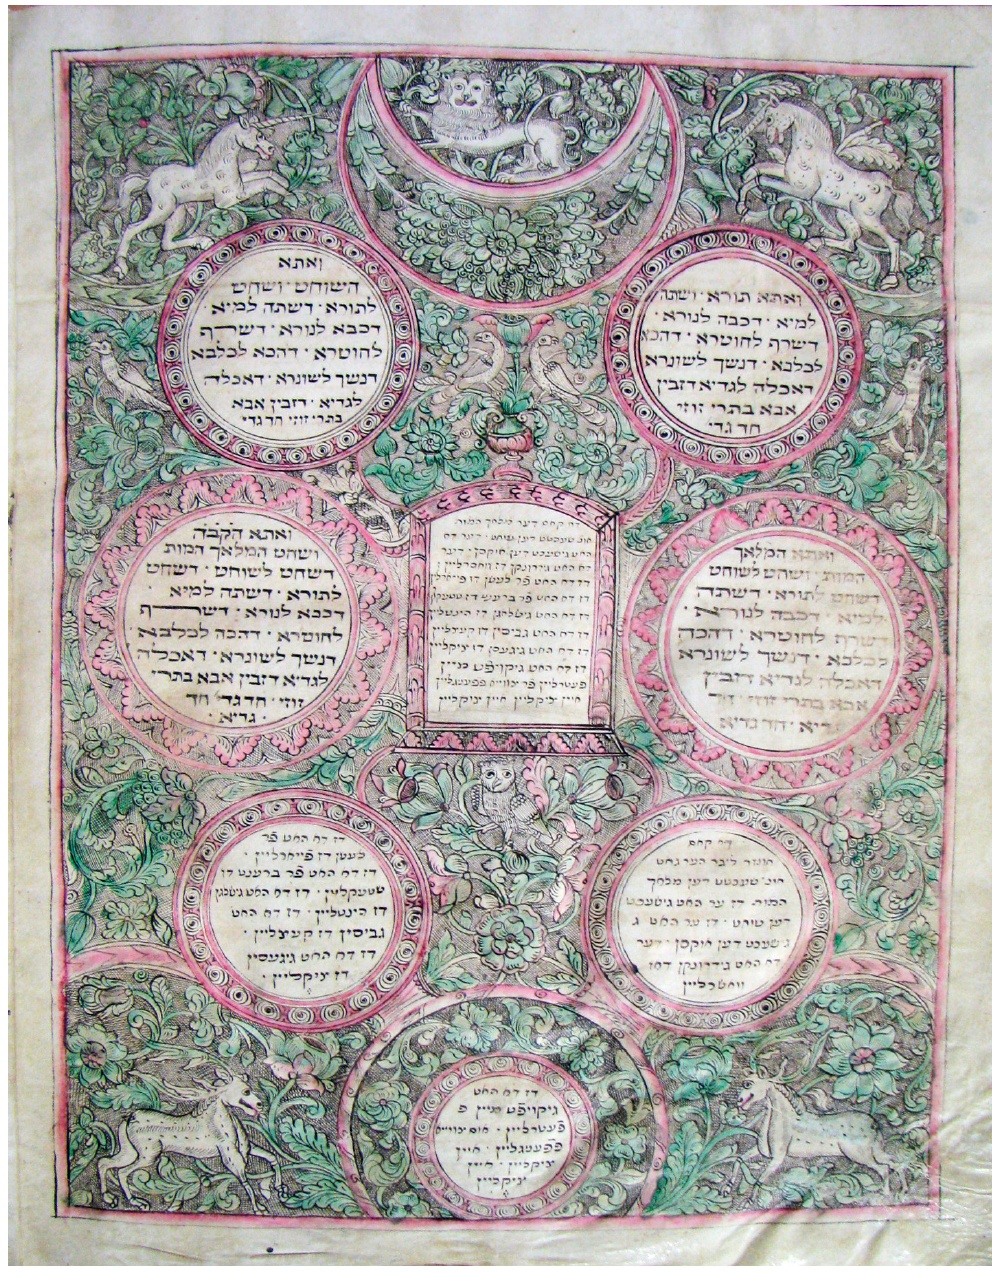
Figure 8. “Passover Haggadah”, Ihringen, 1732; Jerusalem, The Israel Museum, Ms. 181 / 48, Fol. 26v. Used by